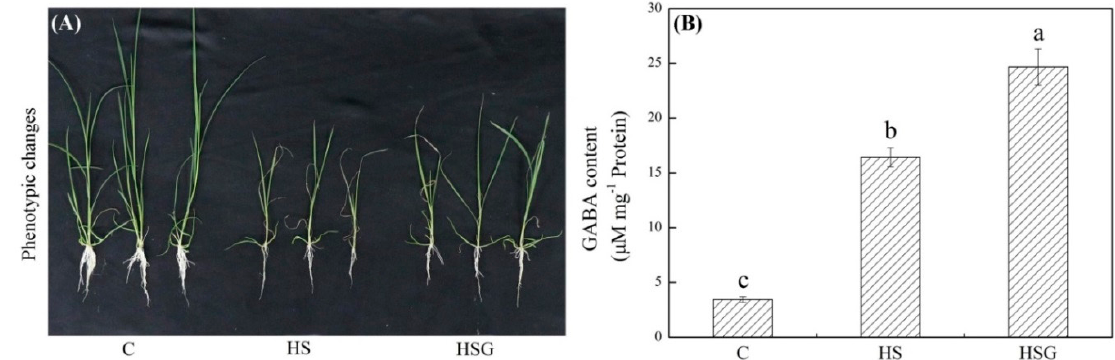
Figure 1. Effects of exogenous γ -aminobutyric acid (GABA) on ( A ) phenotypic changes and ( B ) endogenous GABA content in leaf of creeping bentgrass under heat stress. Vertical bars indicate ± SE of mean ( n = 4) and different letters above columns indicate significant differences ( p ≤ 0.05). C, control (normal condition); HS, heat stress; HSG, heat-stressed plants pretreated with GABA.